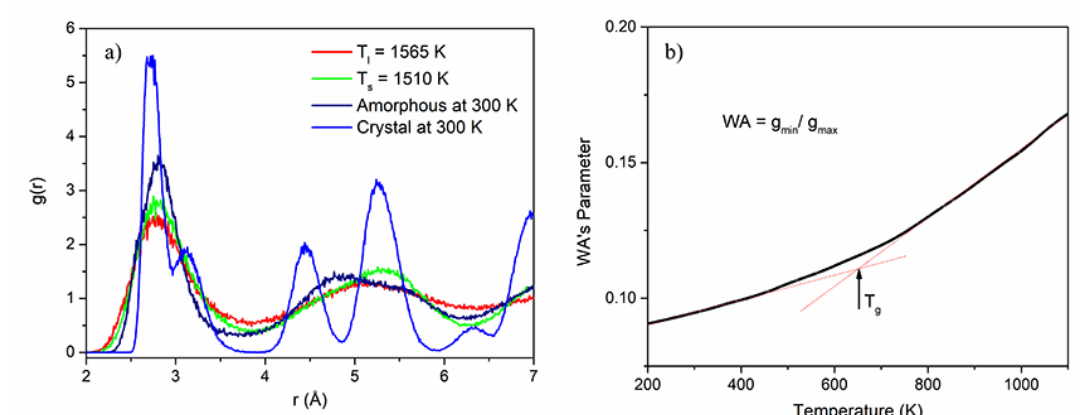
Figure 3. a) Total RDF curves obtained during heating to determine the liquidus and solidus temperatures and, during cooling-down at a cooling rate of 5 K/ps for the Cu